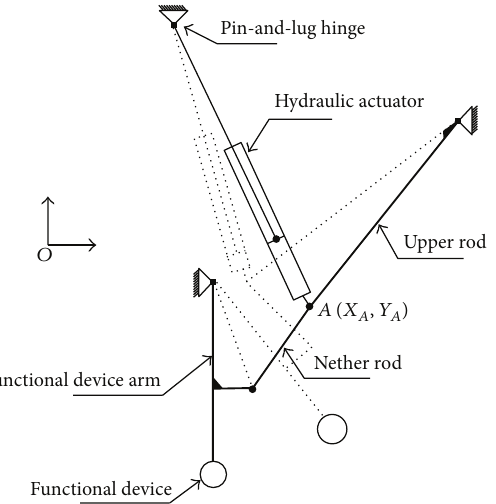
Figure 4: Schematic of the airborne retractable mechanical